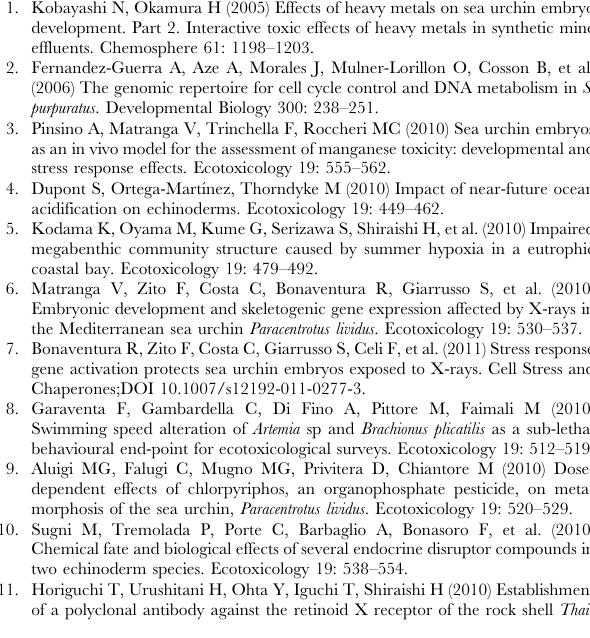
Table S2 Data of expression level are reported as a fold difference from control at 5, 9, 24 48 hpf. Table S3 Data of expression level are reported as a fold difference from control at 5, 9, 24 48 hpf at